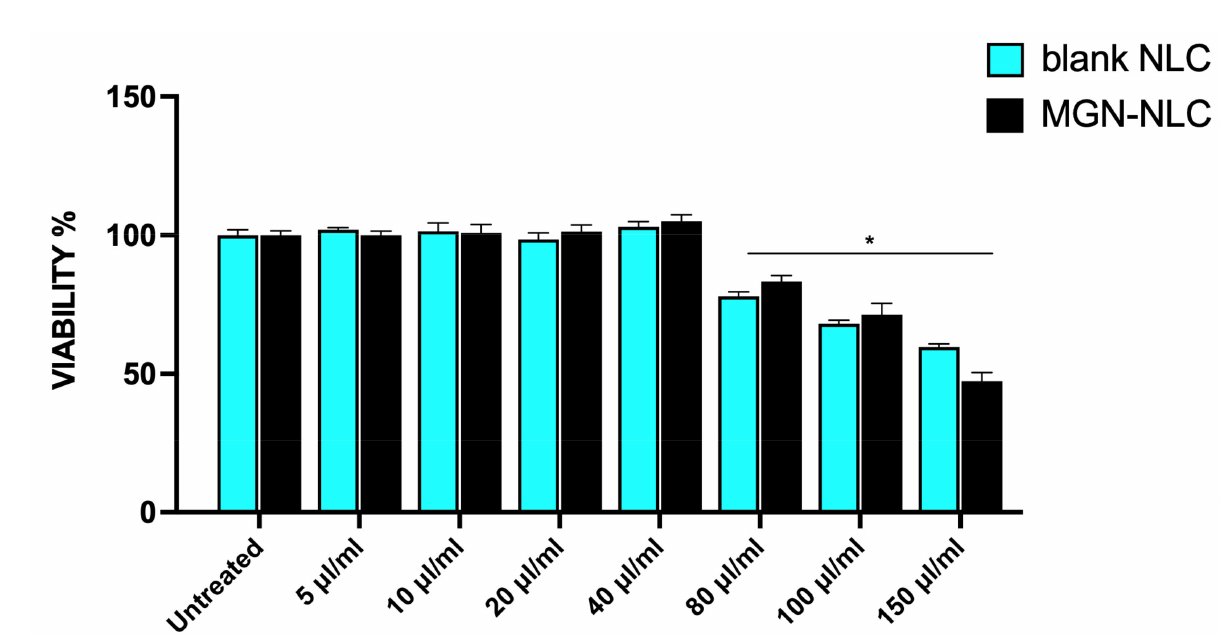
Figure 6. The viability assay in ARPE-19 cells measured by bromide 3-(4,5-dimethylthiazol-2-yl)-2,5- diphenyltetrazolium (MTT) assay. * p < 0.5 versus